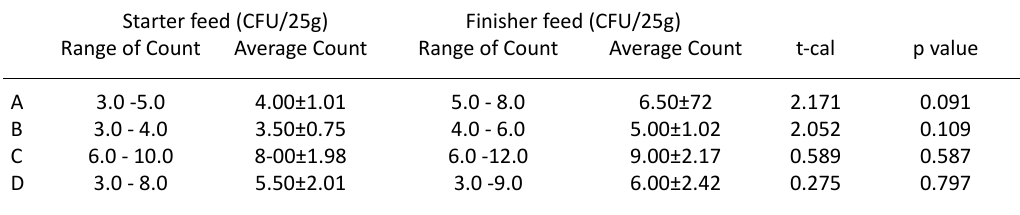
table 2. Total Viable Bacterial Count of Chicken Feeds from Mando, Kaduna Starter feed